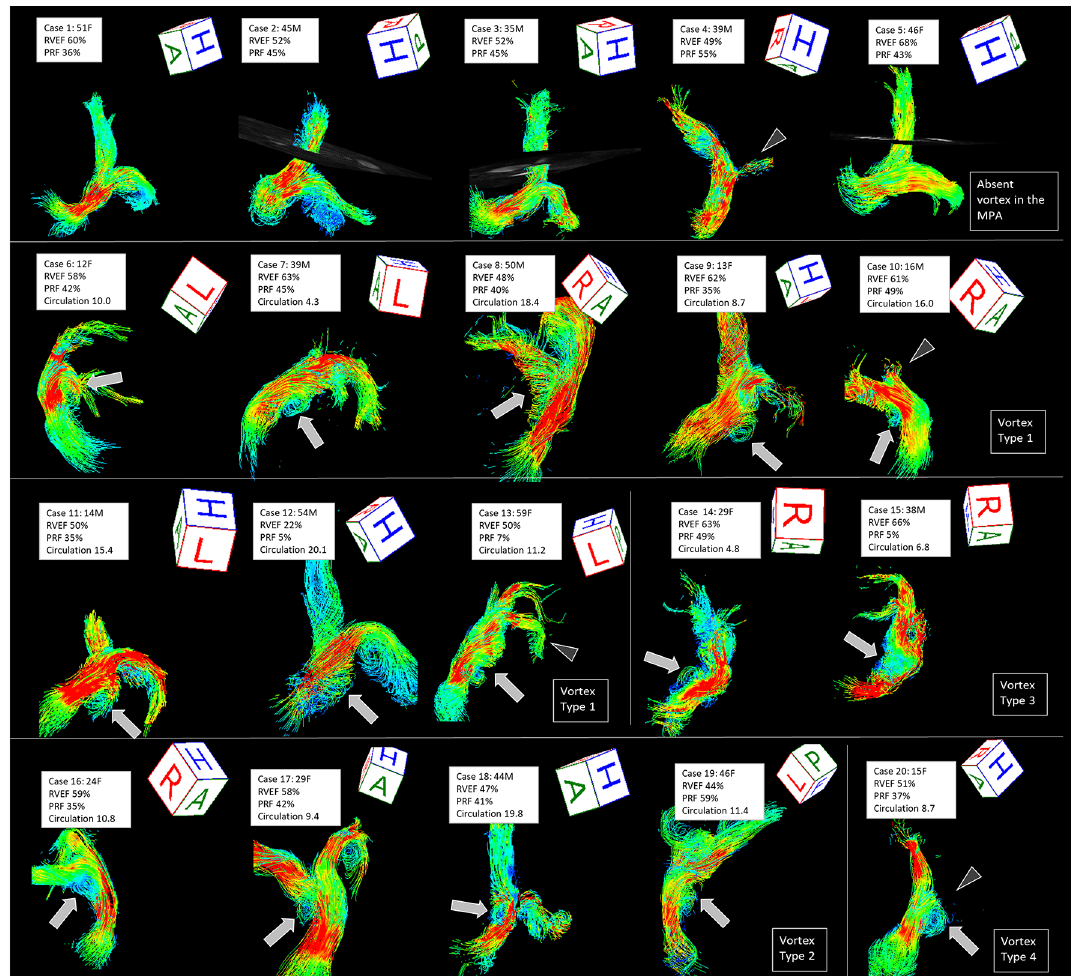
Figure 5. Streamline imaging flows of the pulmonary arteries of 20 patients with repaired Tetralogy of Fallot. Case 1–5 did not show a vortex in the main pulmonary arteries (MPA), however, there were vortical or helical flows in the right and left PA in some patients. Case 6–20 showed vortex formation in the MPA. Vortices typically originated posteriorly in the MPA (Type 1: Case 6–13) and formed helices. Other vortices originated from the MPA bifurcation to the right PA (Type 2: Case 16–19), at the proximal right PA (Type 3: Case 14, 15), or from the MPA bifurcation to the left PA (Type 4: Case 20). Arrows indicate vortices and arrowheads indicate the left pulmonary artery stenosis. F female, M male, RVEF right ventricular ejection fraction, PRF pulmonary regurgitant fraction, Circulation longitudinal integral circulation value. Flow visualization was performed using 4D flow postprocessor software (iT Flow; Cardioflow Design. Inc., Tokyo,